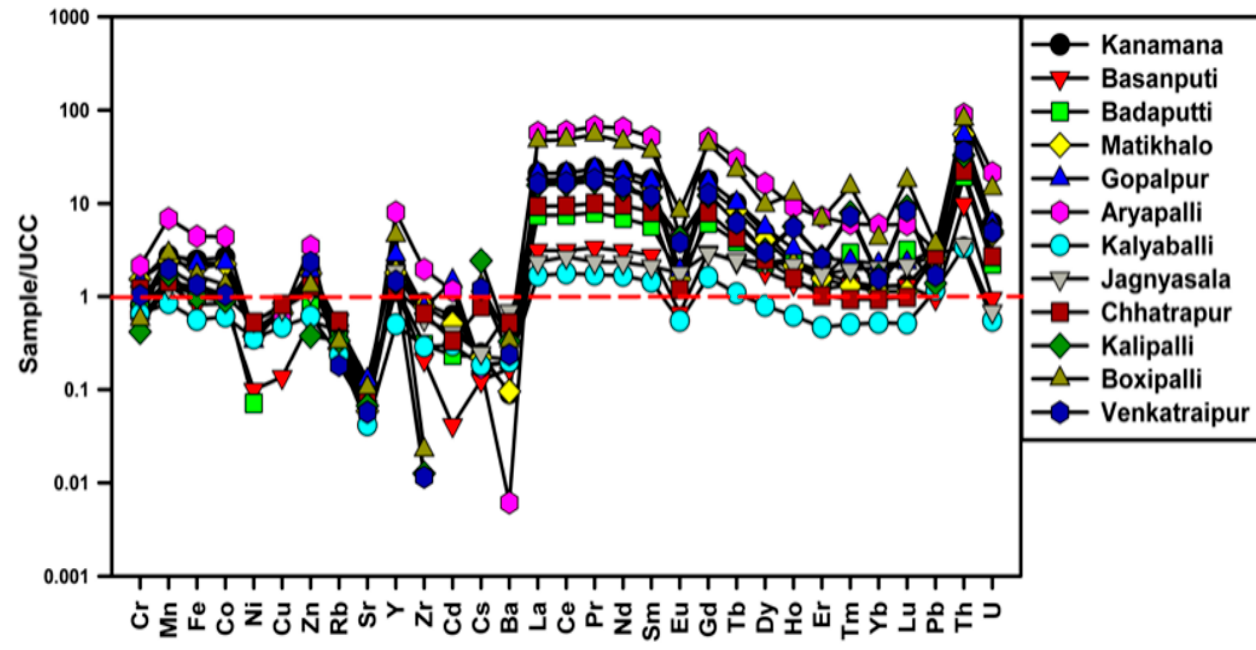
Figure 2. Plot showing UCC-normalized TEs and REEs patterns.